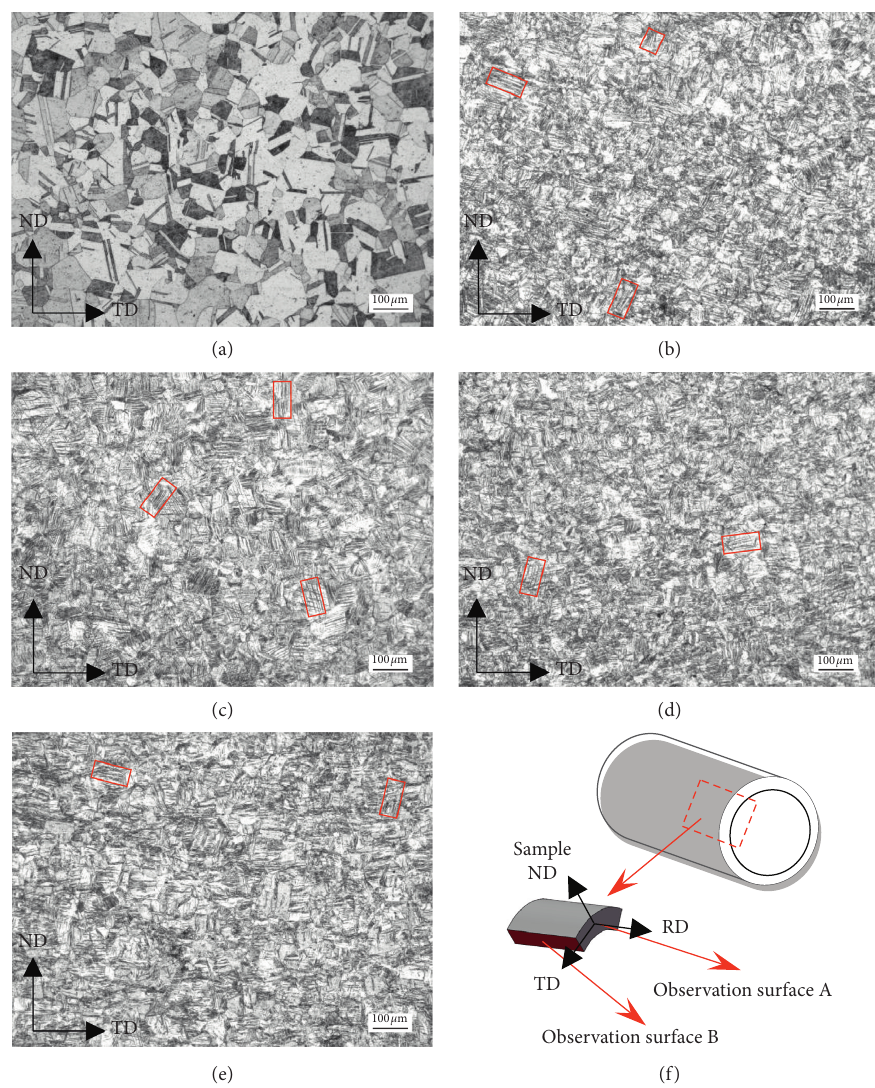
Figure 3: Distribution of metallographic structure observation surface (A) and observation surface of deformation section perpendicular to the direction of the pipe. (a) Section I. (b) Section II. (c) Section III. (d) Section IV. (e) Section V. (f) Observation surface of metallographic